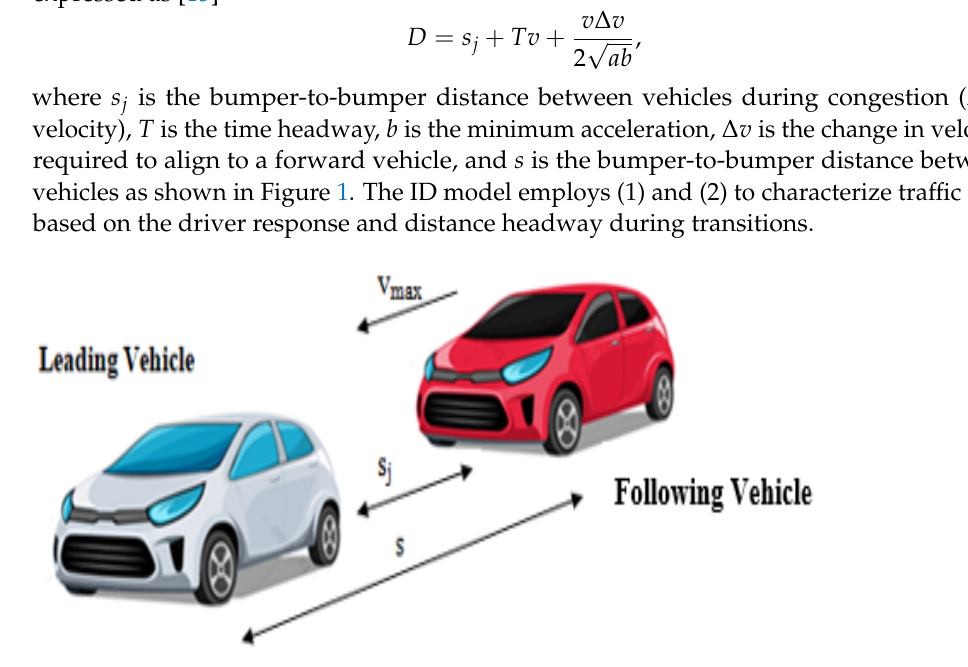
Figure 1. The parameters for the ID